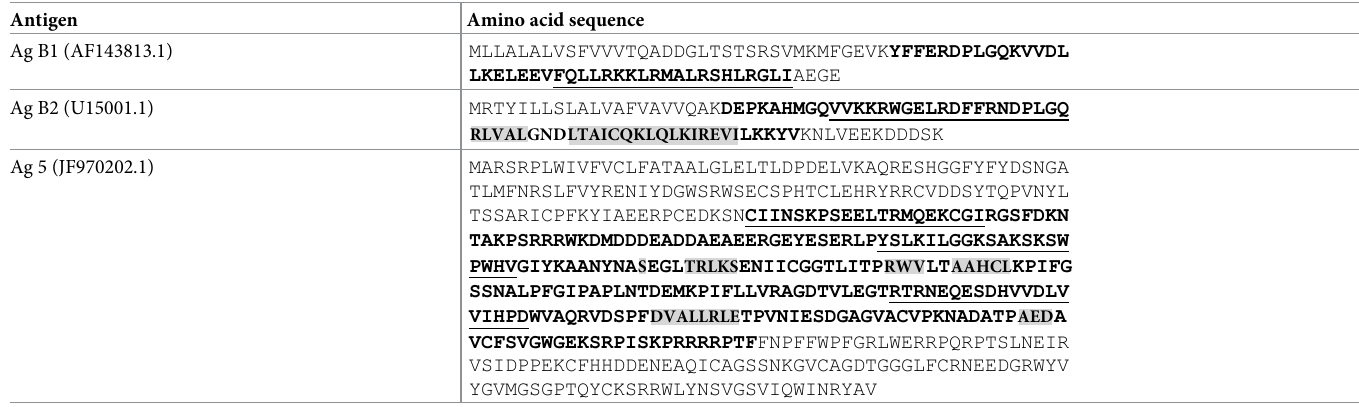
Table 2. Amino acid sequences of the antigens B1, B2 and Ag5 of Echinococcus granulosus (G1 genotype). The whole amino acid sequence for each antigen is shown. Also for each antigen, the most antigenic epitopes as predicted with the SVMTriP program are underlined; the alpha-helix regions as predicted with the PreSSAPro pro- gram are shadowed in grey; and the amino acid sequences corresponding to the cDNAs amplified with the specific PCRs and cloned into the pGEX-4T3 expression vector are in bold. The GenBank accession number for each antigen is indicated between parentheses. Antigen Amino acid sequence Ag B1 (AF143813.1)